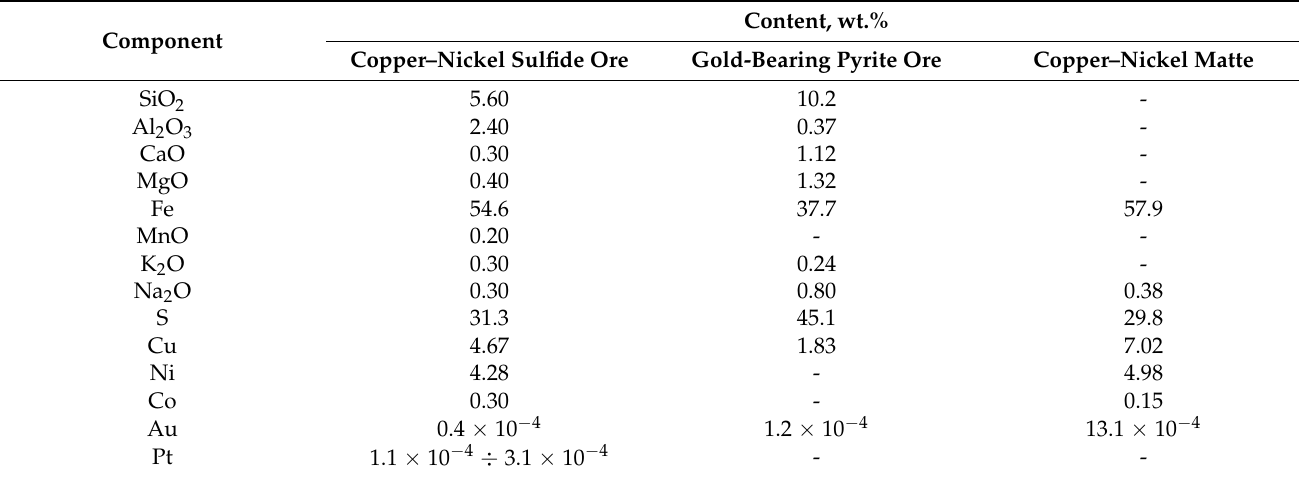
Table 1. Chemical composition of the investigated materials.